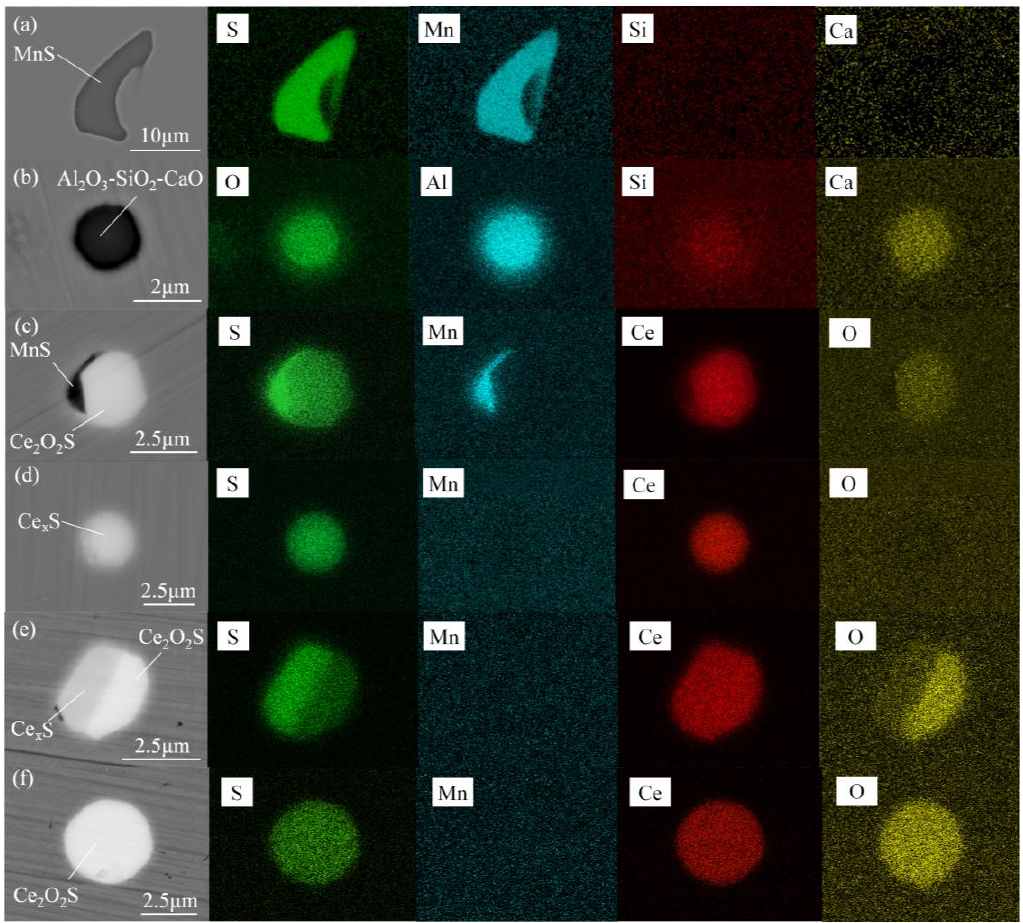
Figure 5. Morphology and elemental mapping of typical composite inclusions: ( a , b ) 0 ppm, ( c ) 52 ppm, ( d ) 139 ppm, 171 ppm, ( e , f ) 256 ppm, 340 ppm.